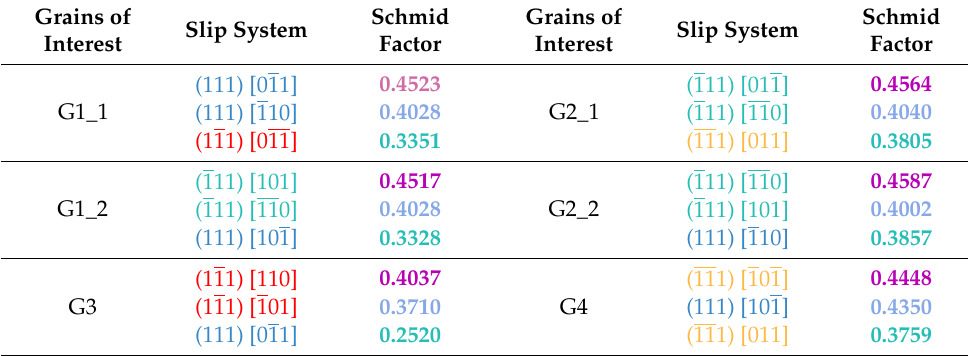
Table 1. Schmid factor of different slip systems in